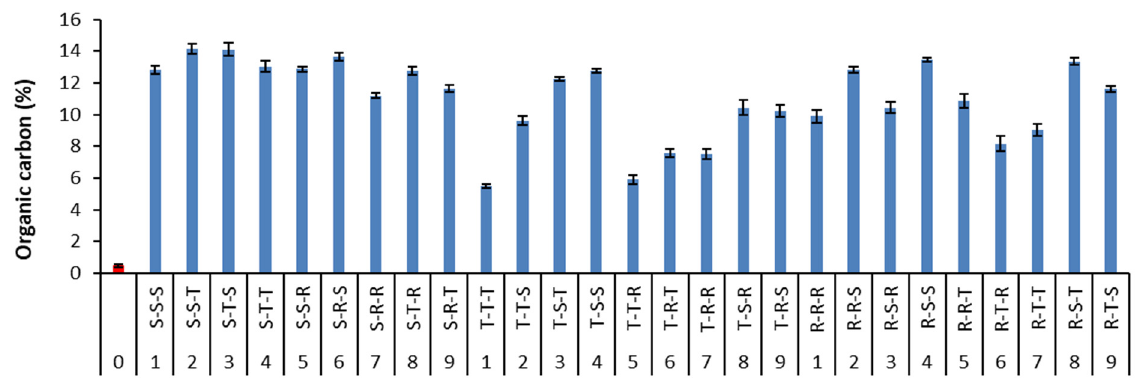
Figure 9. Enrichment of smelter contaminated soil with organic carbon as a result of sequential soil washing with biosur- factants (mean ± SD, n = 2).